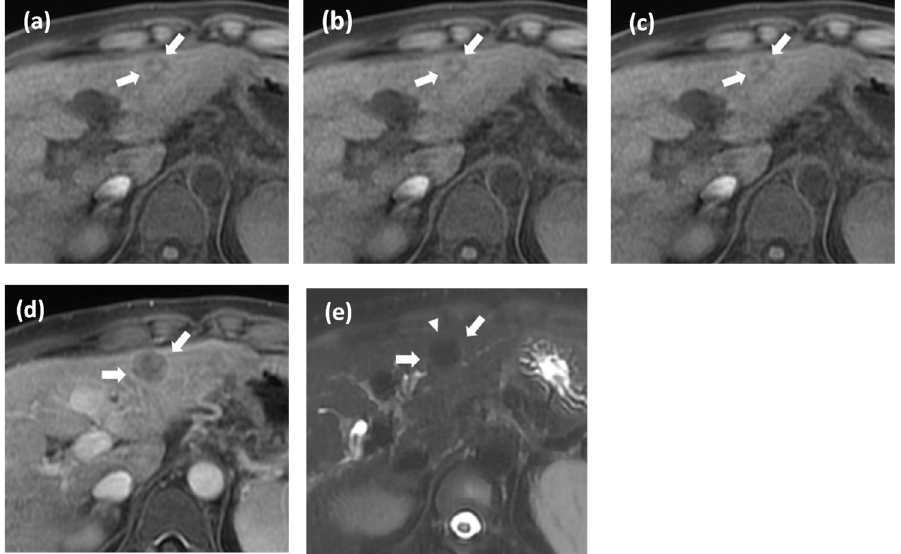
Figure 4. Histologically proven hepatocellular carcinoma (HCC) in a 35-year-old woman with chronic hepatitis B. Gadoxetate disodium-enhanced MRI ( a – d , arrow) shows a 17-mm observation with a smaller inner nodule showing different imaging characteristics than the larger outer nodules on precontrast T1 image ( a ). This demonstrates the nodule-in-nodule. This observation does not show nonrim arterial phase hyperenhancement ( b ) in the nonperipheral washout on portal venous phase. ( c ) It shows enhancing capsule in the portal venous ( c ) and transitional phase ( d ). Thus, it is categorized as LR4 according to major features only. The observation shows suspicious mild T2 hyperintense foci within the nodule (arrowhead; e ). Our decision tree algorithm classifies this nodule as HCC.